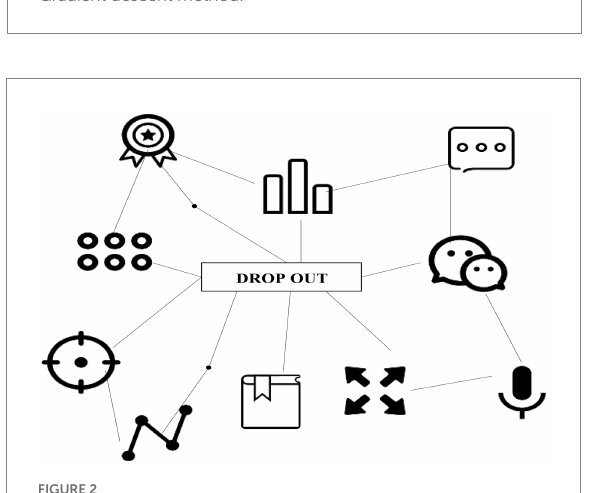
FIGURE 2 Dropout performance